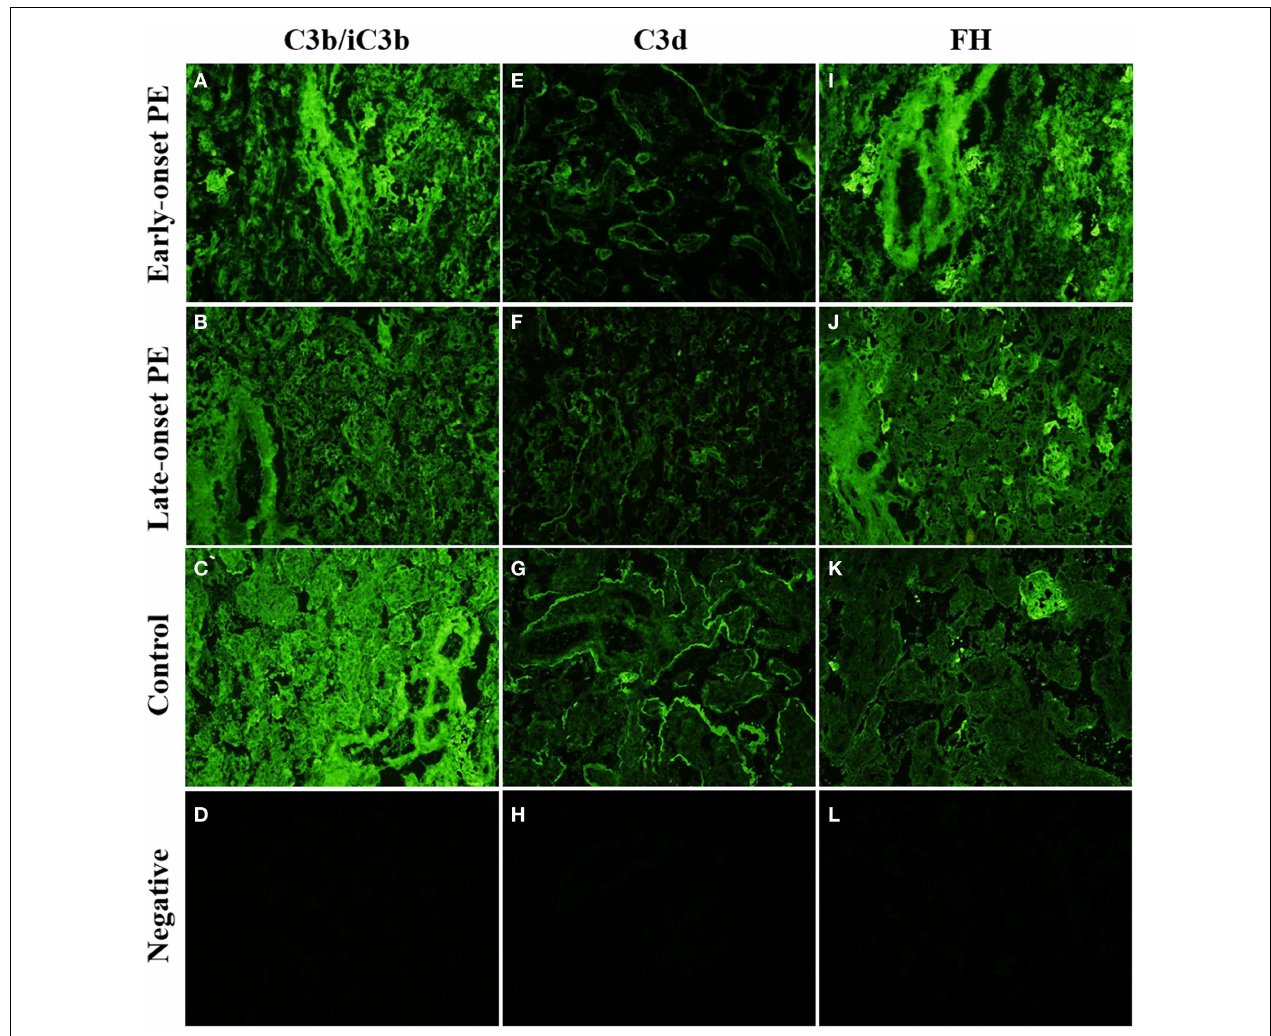
pattern is often interrupted in PE (E,F) where physical damage to the syncytium causes increased rate of syncytial shedding.Top row (A,E,I) : early-onset PE. Middle top row (B,F,J) : late-onset PE. Middle bottom row (C,G,K) : control. Bottom row (D,H,L) : negative control (antibody I omitted). 20 ×